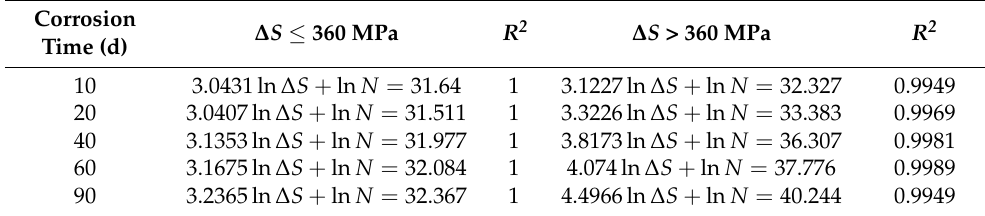
Table 2. S-N curve under different corrosion degree.